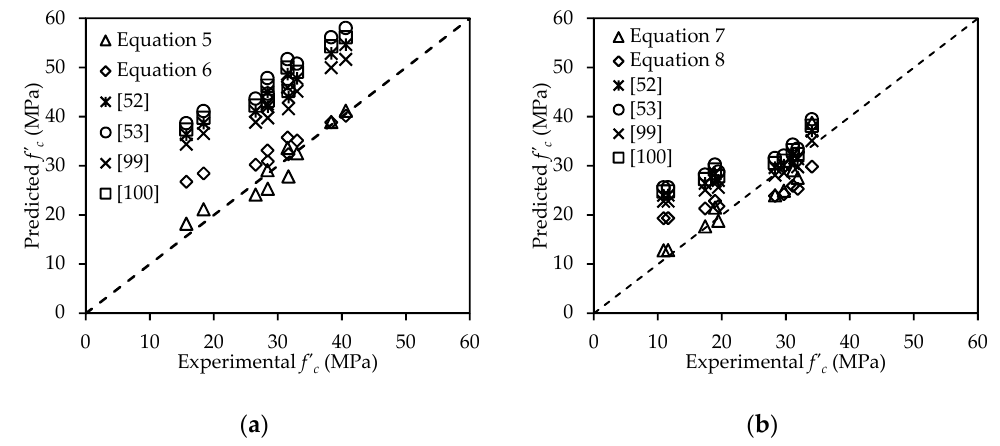
Figure 9. Predicted versus experimental cylinder compressive strength for mixtures with slag:fly ash of: ( a ) 3:1; ( b ) 1:1.